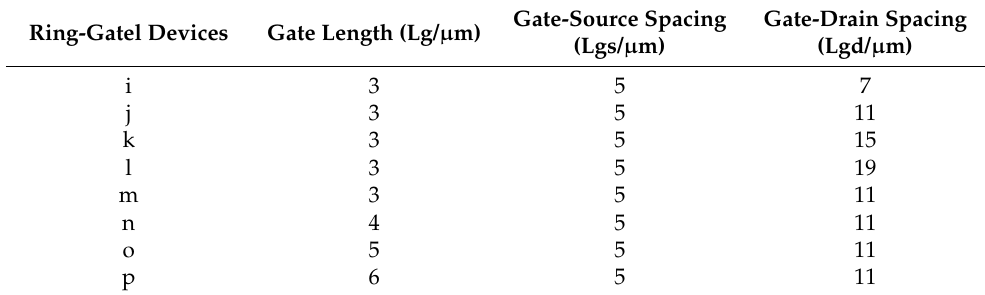
Table 3. Gruoping of ring-gate AlGaN/GaN HEMT devices with different gate length and gate- drain